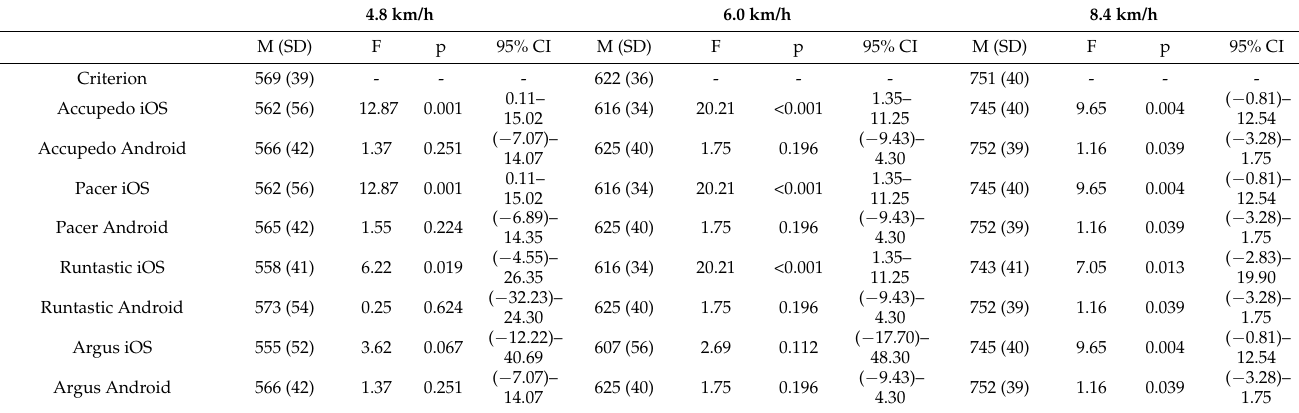
Table 2. Results of repeated measures ANOVA for step count and comparison with criterion measure.